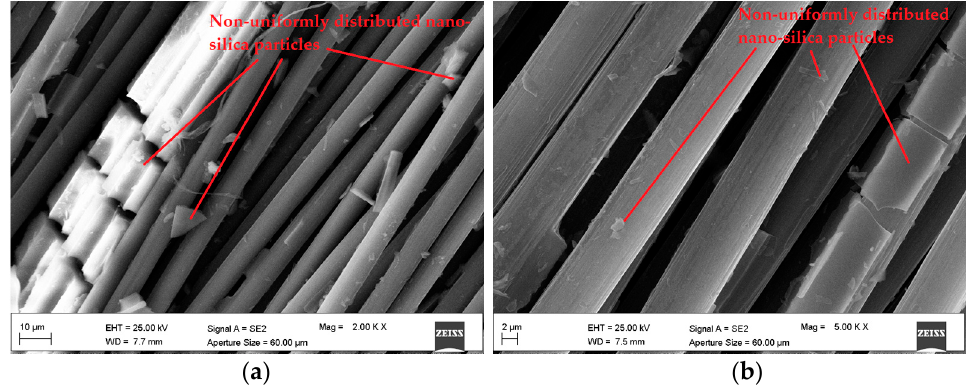
Figure 10 . SEM images of C-NS yarns. Magnification ( a ) 2.00 Kx and ( b ) 5.00